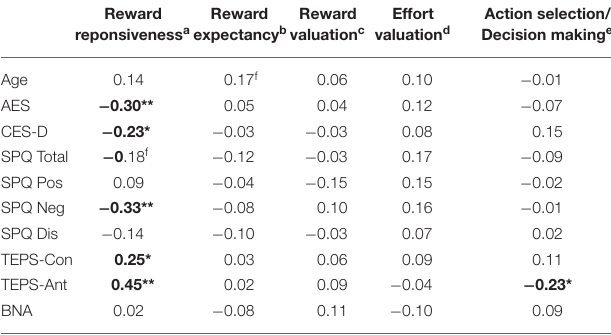
TABLE 3 | Bivariate correlations between clinical measures and motivation tasks.